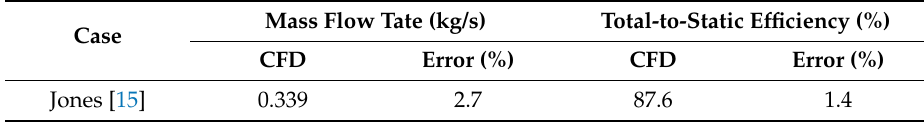
Table 3. Comparison of total-to-static efficiency and mass flow rate between computational fluid dynamics (CFD) results and experimental data [15].